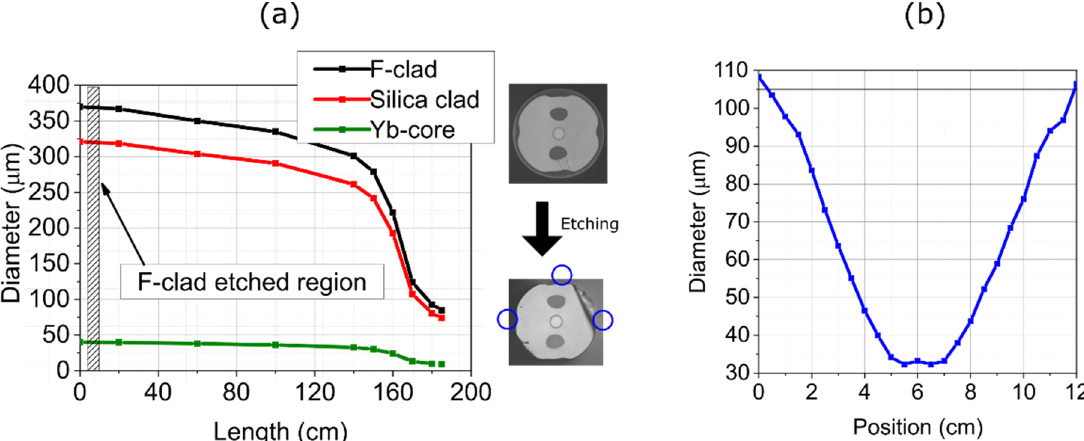
Figure 3. ( a ) Used Yb-doped tapered fiber diameters on length dependence and cross-section photo before and after etching of its second F-doped silica cladding; blue circles on cross-section photo schematically depict positions of the pump-feed bitapered fibers. ( b ) Typical diameter dependence on the length of the etched bitapered fiber.